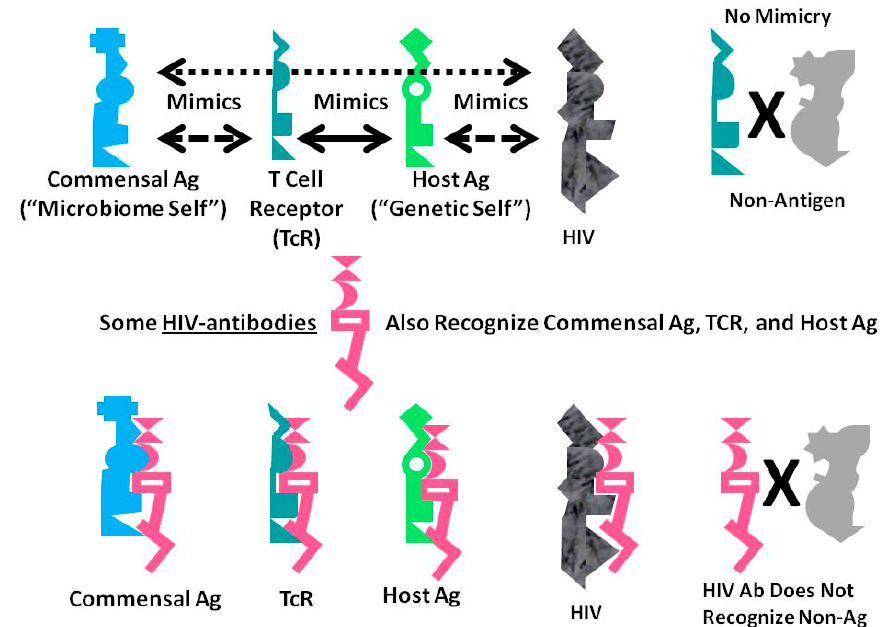
Figure 6. Graphical abstract of the results reported here demonstrating the range of consequences that result from the fact that HIV antigens mimic human TCR. Previous research [3–7] has demonstrated that human TCR mimic host proteins and the host microbiome. It has been proposed that the microbiome is selected for its compatibility with the host immune system by camouflaging itself through such molecular mimicry. This process has led to the proposal that the immune system not only mediates genetic “self”, but also the integrated holobiont “self” composed of the host and its microbiome. The data reported here strongly supports the contention that HIV mimics all components of the holobiont including, host TCR, host proteins and microbiome proteins. In order for the host immune system to eliminate HIV, it is, therefore, very likely that it will have to attack its own T cells, some of its tissues and specific components of the host microbiome. Thus, the mechanism proposed here suggests how an HIV infection, by altering specific elements of self-tolerance, may also alter tolerance for particular components of the microbiome producing some of the gut and skin symptoms commonly seen in people with AIDS. In sum, the production of lymphotcytotoxic autoantibodies in AIDS due to HIV-mimicry of host TCR should also induce autoimmunity not only against TCR, but a wider autoholoimmunity against the holobiont microbiome as well.